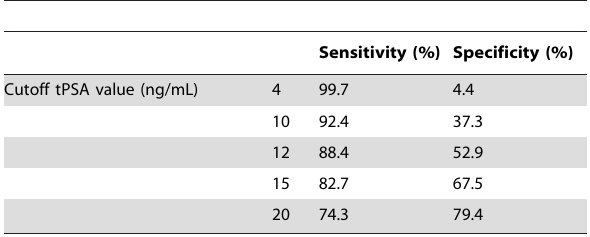
Table 4. Different sensitivities and specificities in different tPSA cutoff